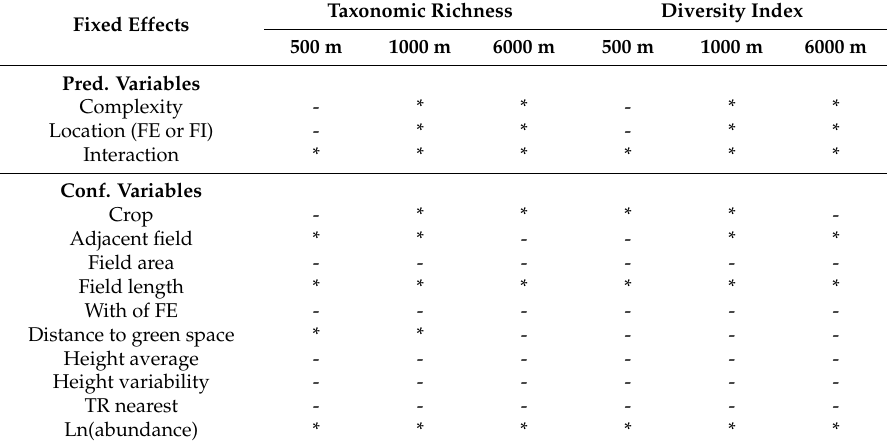
Table 2. Summary of the impact of the fixed effects on taxonomic richness (ln transformed) and diversity index at the different spatial scales. Pred. variables = predictor variables; Conf. variables = confounding variables. Confounding variables included crop in the field interior (FI; soybean or corn), closest adjacent field (soybean, corn, grassland or developed), area of FI (m 2 ), width of the field edge (FE; m), length of the FE (m), distance to nearest non-arable (green) space > 1 ha, average vegetation height in both FI and FE (cm), variation of vegetation height (cm), correction factors for TR in the nearest sampling field weighted by buffer overlap and ln of abundance. For the predictor variables, * means that the estimated parameter is significantly different from zero. For the confounding variables it means that the variable could not be excluded from the model based on the LRT test, which means that either the main effect, the interaction effect with location or both effects are significant.